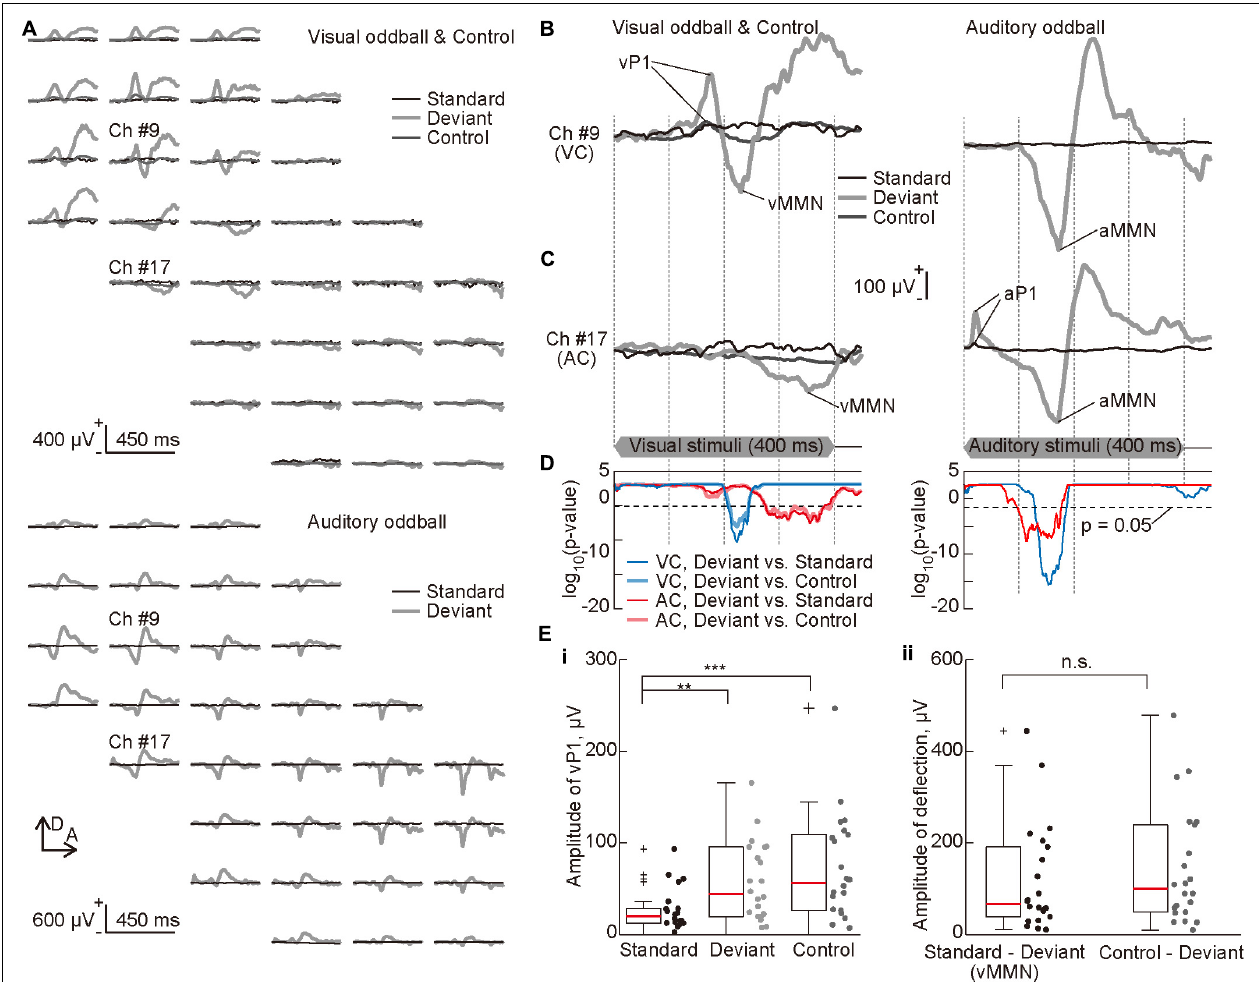
FIGURE 3 | Deviance detection properties of visual mismatch negativity (vMMN). (A) Representative mapping of visual evoked potential (VEP) recorded in the visual oddball and control paradigms (top) and auditory evoked potential (AEP) recorded in the auditory oddball paradigm (bottom). The standard (black lines), deviant (bold light gray lines), and the control (dark gray lines) responses were approximately aligned in the spatial coordinates of the recording sites of the surface microelectrode array. (B,C) Representative time courses of evoked responses in the oddball paradigms. The traces represent VEPs (left) and AEPs (right) from indicated recording sites (B) in the visual (#9) and (C) auditory cortices (#17). Prominent components of these traces, i.e., visual P1 (vP1), vMMN, auditory P1 (aP1), and auditory MMN (aMMN) are pointed. The time course of stimulus presentation is indicated at the bottom of the inset. (D) Statistical confirmation of MMN as a negative deflection in the deviant responses. The lines show significance level under the null hypothesis that deviant responses are larger than standard or control responses at a given post-stimulus latency time (Wilcoxon one-sided rank-sum test with Bonferroni correction for 450 comparisons). The blue and red lines indicate significance levels for comparison of deviant and standard responses, and the light blue and pink lines indicate those for comparison of deviant and control responses. The blue and light blue lines indicate the recording sites in the visual cortex, and the red and pink lines indicate the recording sites in the auditory cortex. Horizontal broken lines indicate p = 0.05. (E) The amplitude of (i) vP1 in the standard, deviant, and control responses, and (ii) the negative deflection or MMN quantified in the subtraction of deviant responses from the standard or control responses. Dots indicate the mean amplitudes in the visual cortex of each animal and for each stimulus. Asterisks indicate statistical significance in post hoc analysis: ** p < 0.01; *** p < 0.001 (Wilcoxon one-sided signed-rank test with Bonferroni correction for three comparisons following the Kruskal-Wallis